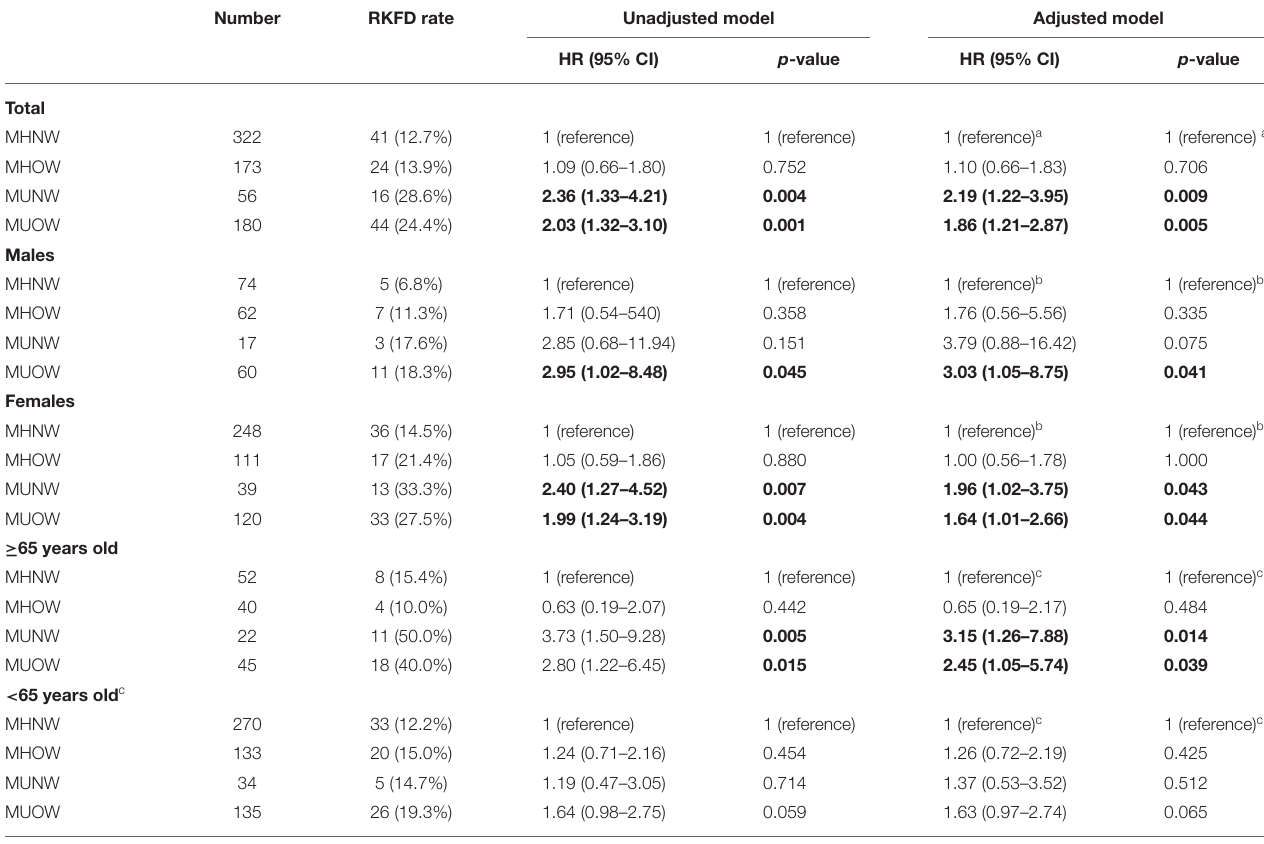
TABLE 5 | Combined effects of sex, age, and MBCS on